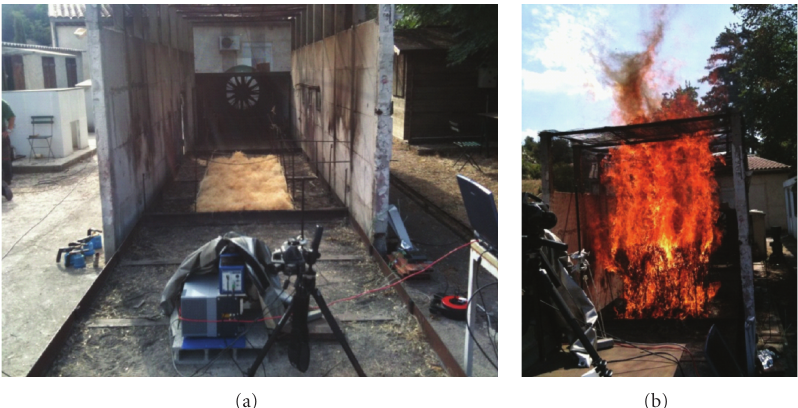
Figure 1: Photographs of the experimental setup showing the arrangement of the 3m × 1m wood shaving fuel bed (a) and of a typical test where kermes oak shrubs were burning (b). The spectrometer is on the foreground.